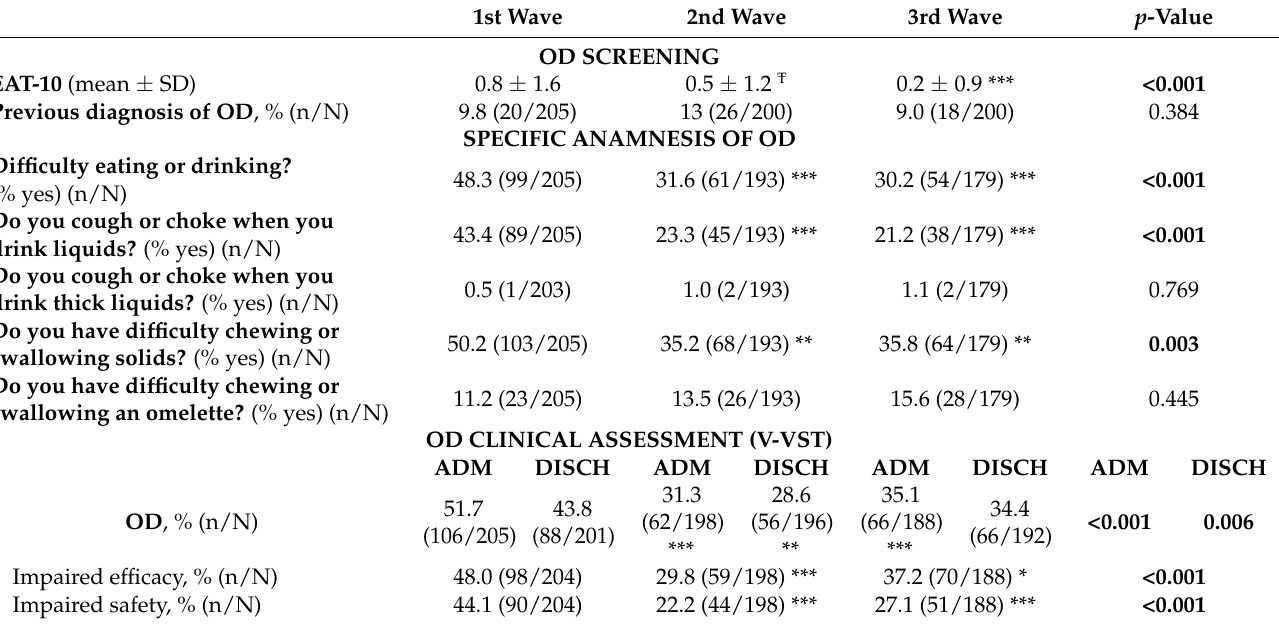
Table 3. Swallowing assessment of the three waves of COVID-19 patients. Table 1. Demographic characteristics of the first three waves of COVID-19